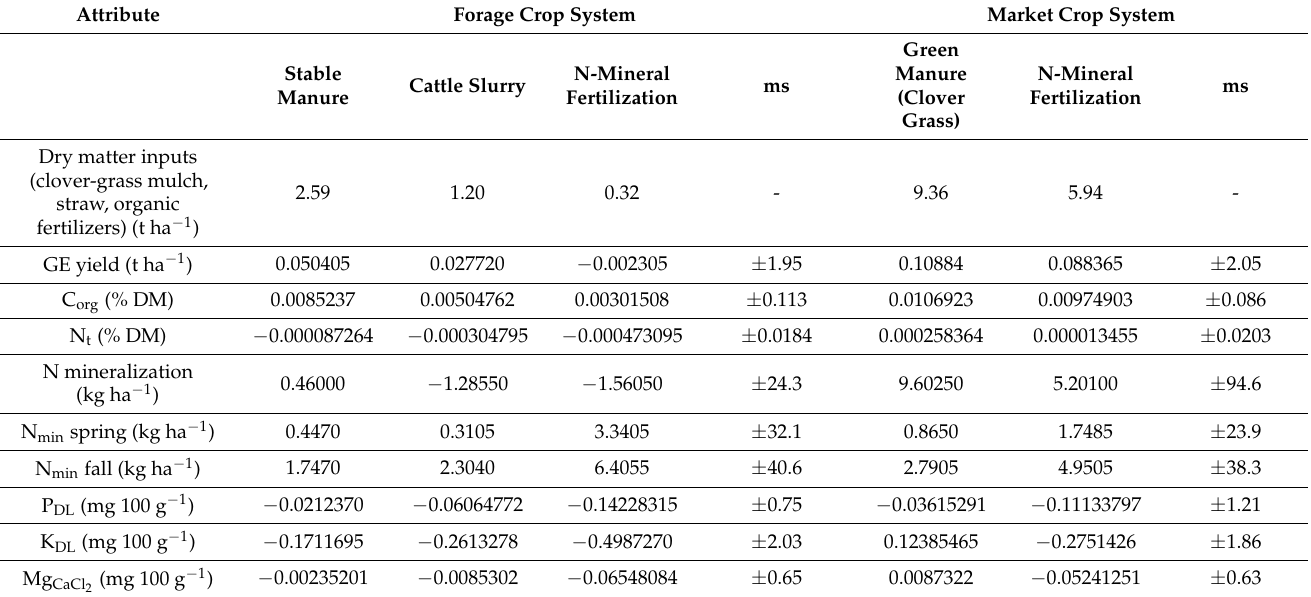
Table 6. Effects of the supply of organic fertilizers and a mineral N fertilizer of comparable application level per year (total N supply) on the annual change of certain characteristics from long-term trials averaged over a loam and sandy soil (mean standard error of the regression,